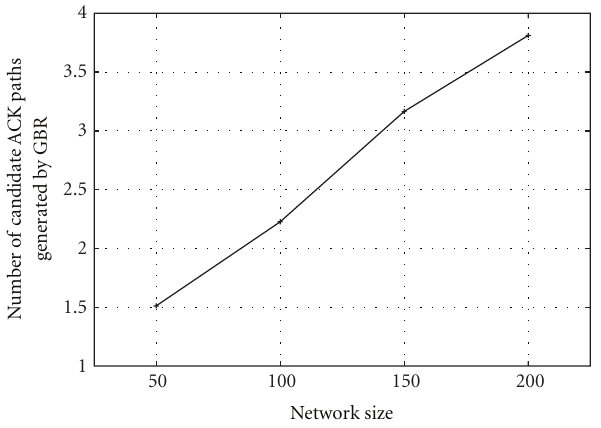
Figure 5: Evolution of the average number of ACK paths generated by GBR as a function of the network